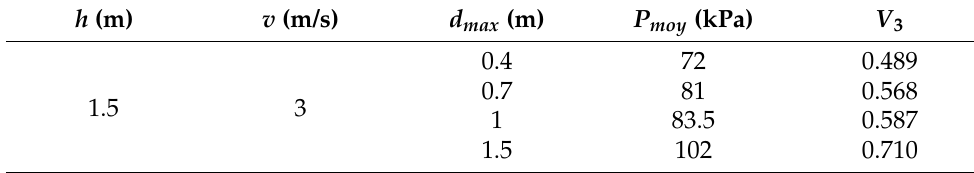
Table 5. Influence of maximal diameter d max on average pressure P moy and vulnerability V